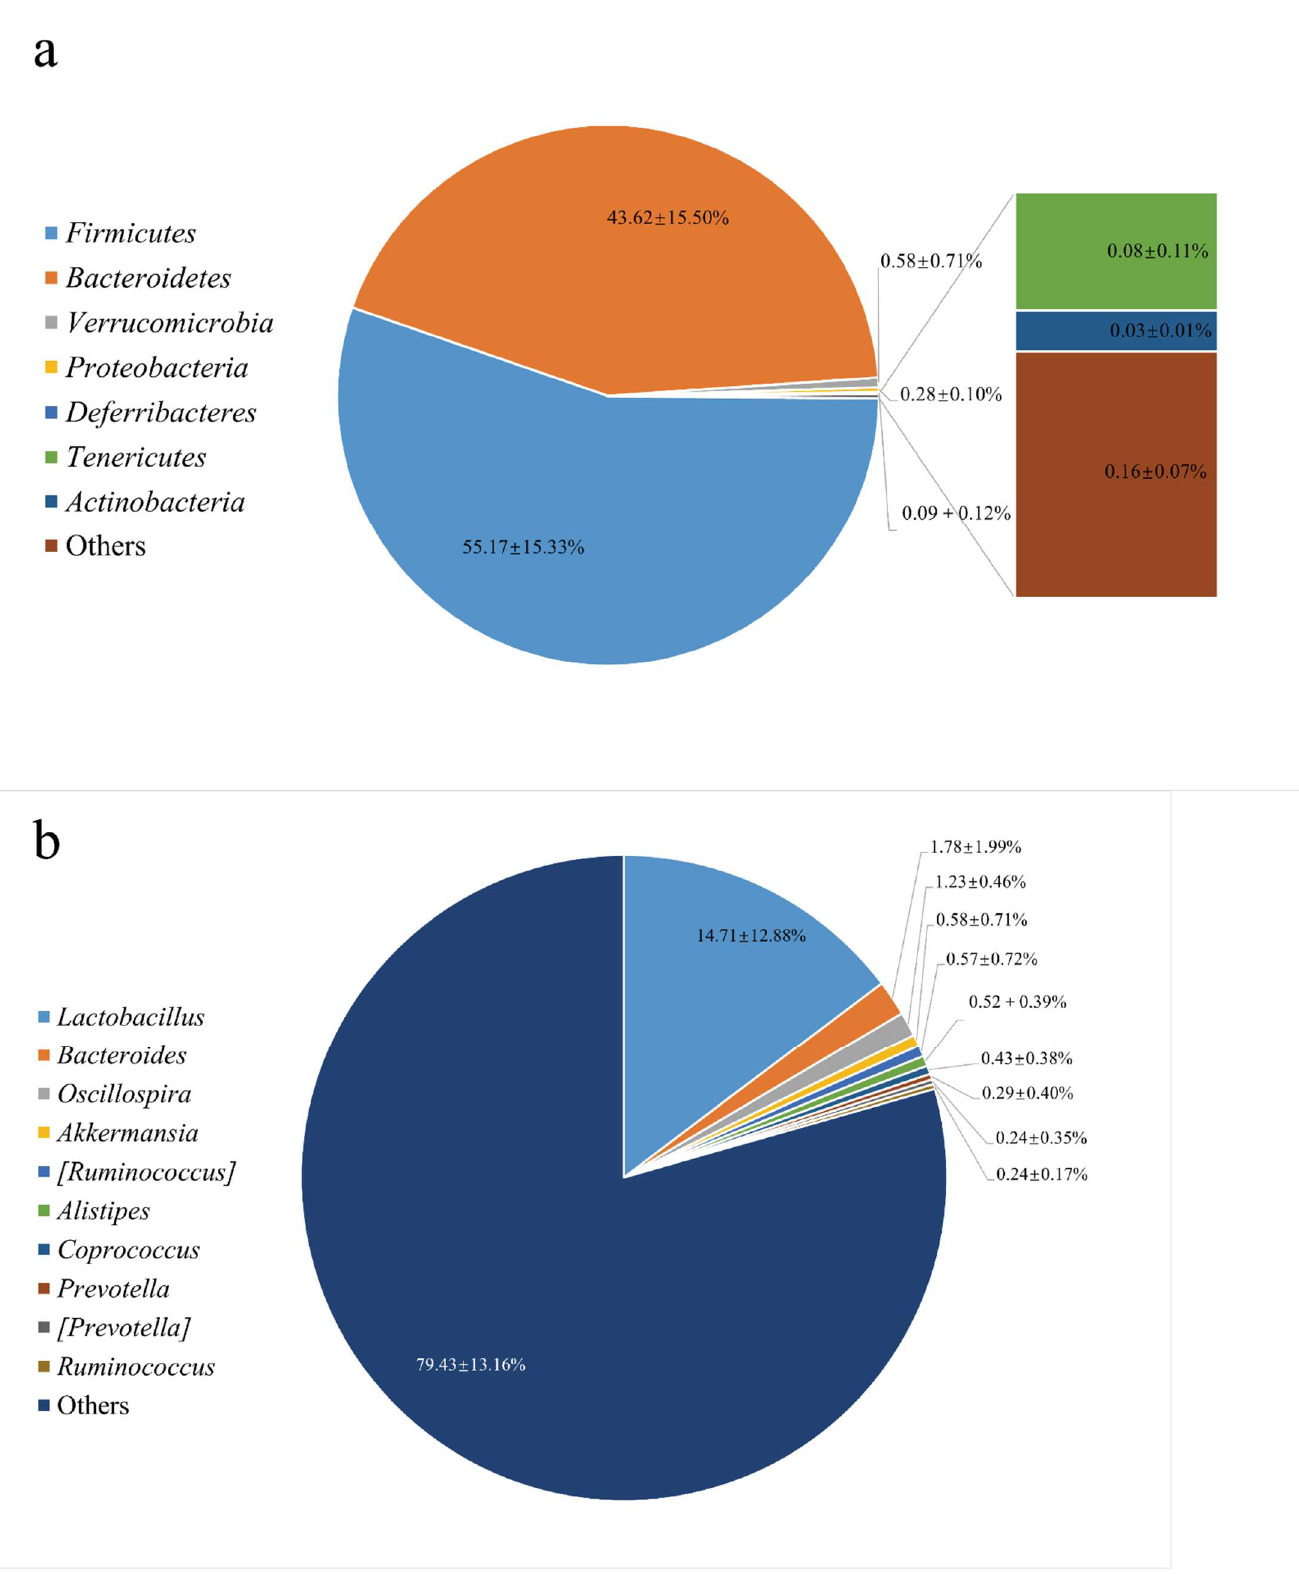
Figure 1. The gut microbiota structure in the feces from C57BL/6 mice. ( a : Phylum Level; b : Genus Level).